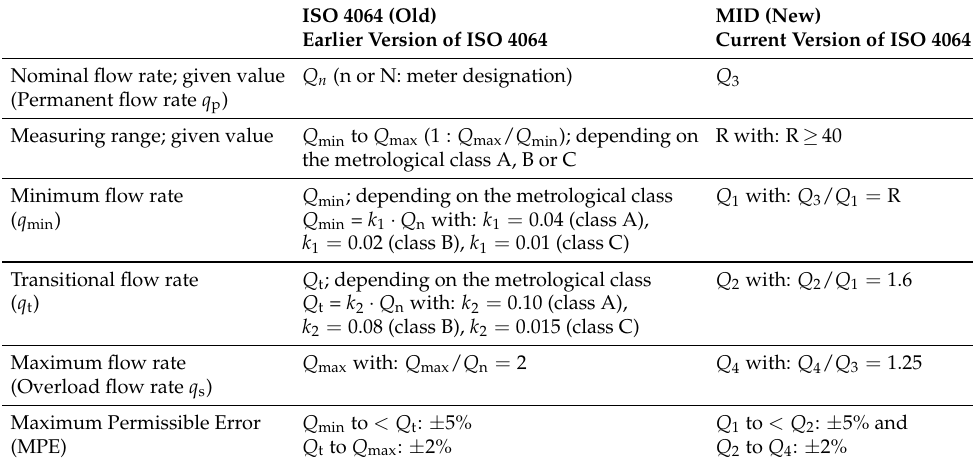
Table 1. Former and new designations and calculations regarding flow measurement points. ISO 4064 (Old) MID (New) Earlier Version of ISO 4064 Current Version of ISO